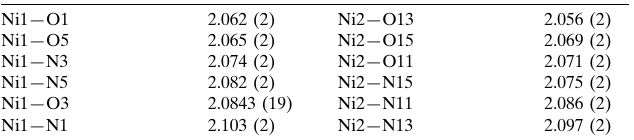
Selected bond lengths (A˚ ).